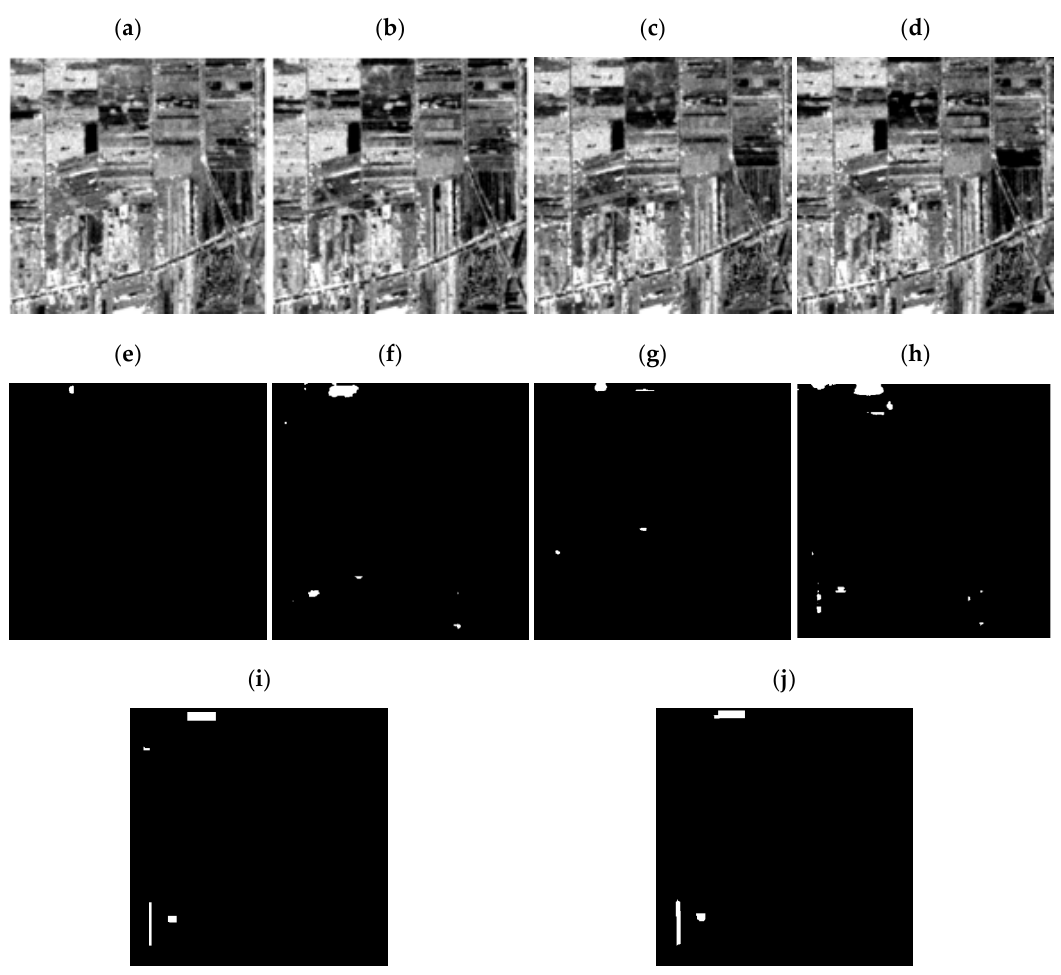
Figure 7. Comparison between each patch size in the first area of the Bangkok site. The resolution of each image is 6 km × 6 km (for SAR pairs 27 November 2008/15 January 2010 and 12 January 2009/21 November 2009, respectively: ( a , c ) Time 1 SAR image, ( b , d ) Time 2 SAR image, ( e , g ) result of 128 × 128 patch size, ( f , h ) result of 256 × 256 patch size, ( i , j ) ground truth).